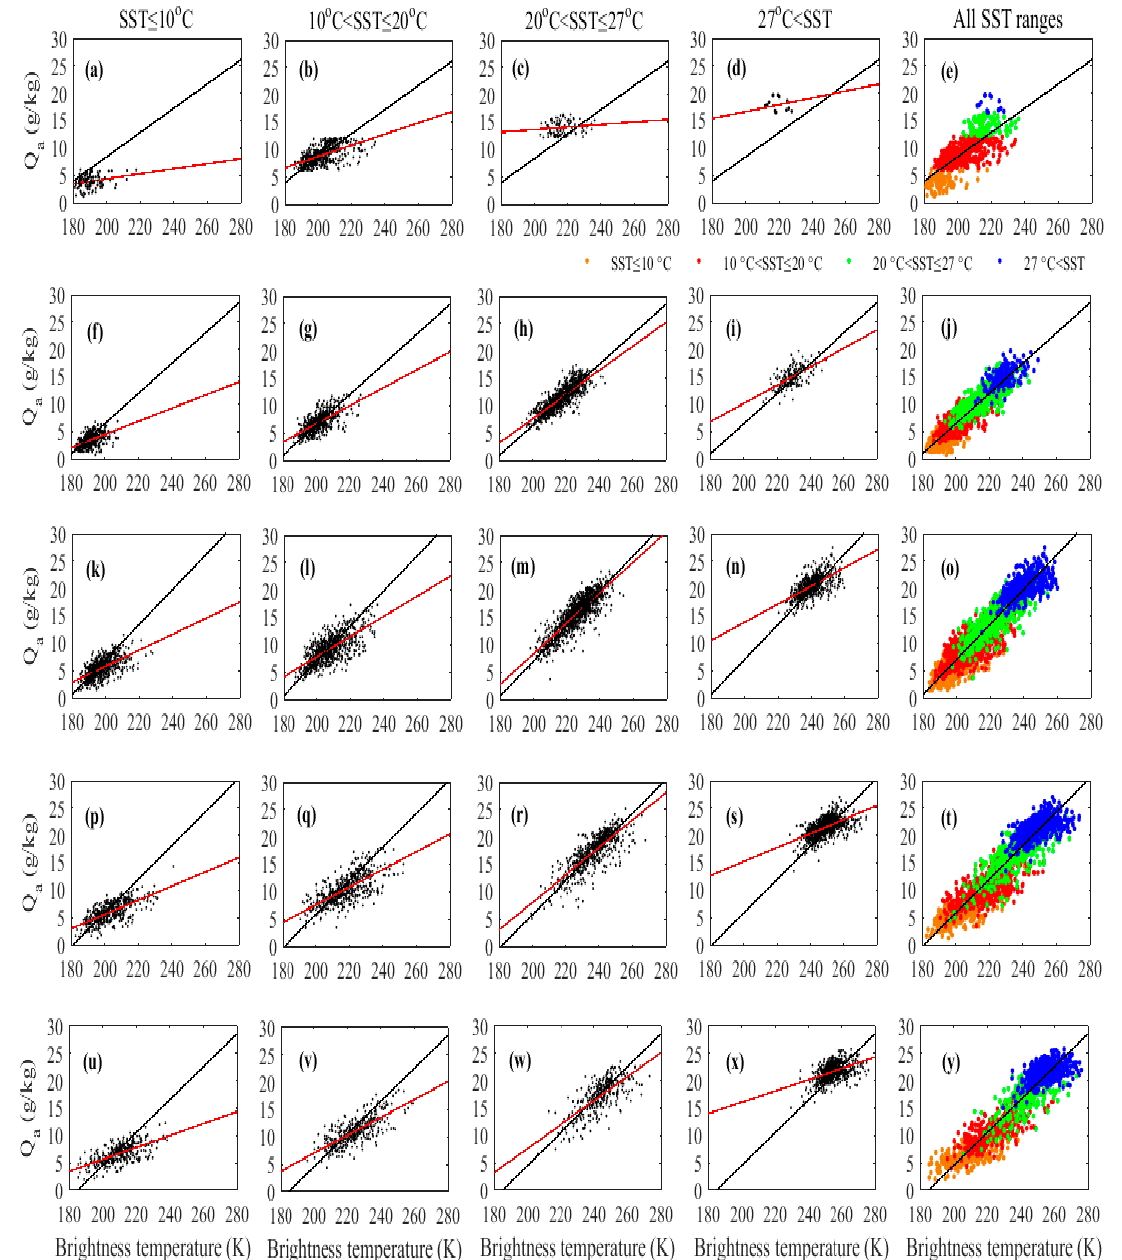
Figure 5. The relationship between T B ,23 V , Q a , and SST. ( a – e ) For H v ≤ 1300 m; ( f – j ) for 1300 m < H v ≤ 1800 m; ( k – o ) for 1800 m < H v ≤ 2300 m; ( p – t ) for 2300 m < H v ≤ 2800 m; and ( u – y ) for H v > 2800 m. Each subfigure shows a linear regression black line calculated using all data of the same H v range; the red line was calculated using the corresponding SST range data.